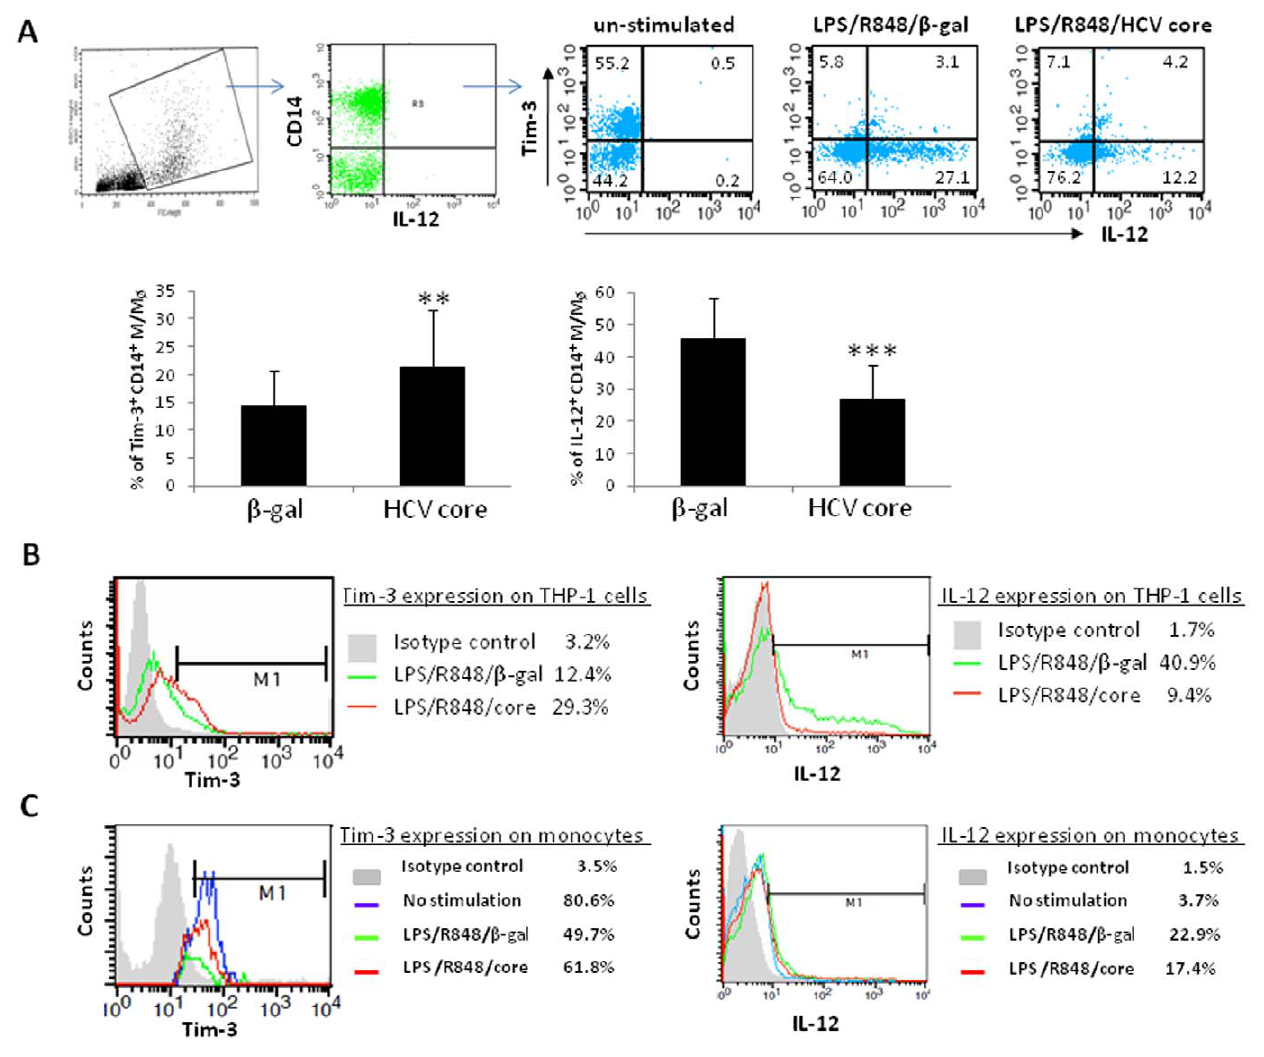
Figure 4. Tim-3 and IL-12 expression in primary CD14 + M/M Ø and THP-1 cells are altered by HCV core treatment. A) Healthy PBMC were treated with b -gal or HCV core and LPS/R848 for 18 h, followed by triple immunostaining and flow cytometric analysis for the expressions of CD14, TIM-3, and IL-12. PBMC were first gated on monocytic populations, and then further gated on CD14 + M/M Ø (R3). Representative dot plots from a healthy subject demonstrate the relationship of Tim-3 and IL-12 expression and their response to b -gal or HCV core treatment. Summary data from 8 healthy subjects indicates the effect of HCV core on Tim-3 expression and IL-12 production in primary CD14 + M/M Ø . Mean values are expressed as percentage of the indicated population. Error bars represent the SD of the mean. The p value (** , 0.01; *** , 0.001) is denoted above the group of study subjects. B) Tim-3 expression and IL-12 production in THP-1 cells 72 h after HCV core or b -gal treatment followed by flow cytometric analysis. The histogram of Tim-3 or IL-12 expression is over-layed upon isotype control and different treatment. The data is reproducible in repeated experiments. C) Tim-3 (left panel) and IL-12 (right panel) expression in purified CD14 + M/M Ø with no stimulation (blue line), LPS/R848/ b -gal treatment (green line), or LPS/R848/core treatment (red